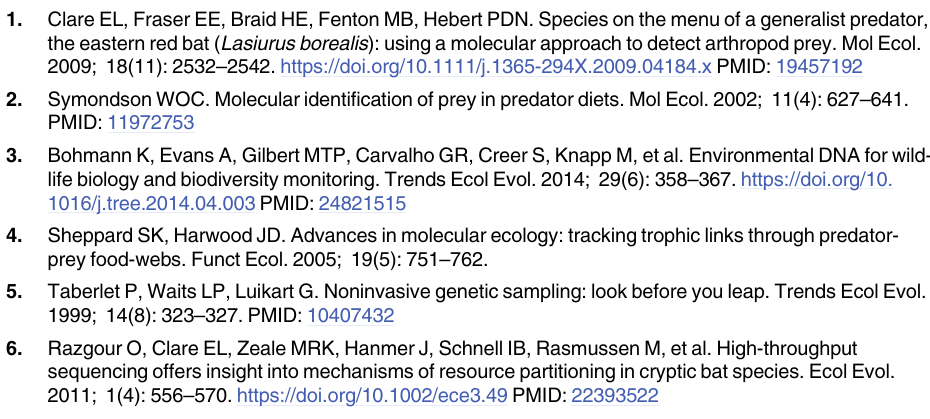
S3 Table. Number of species identified (N.Sp.) number of occurrences (Occ.) in each taxo- nomic group, for each primer